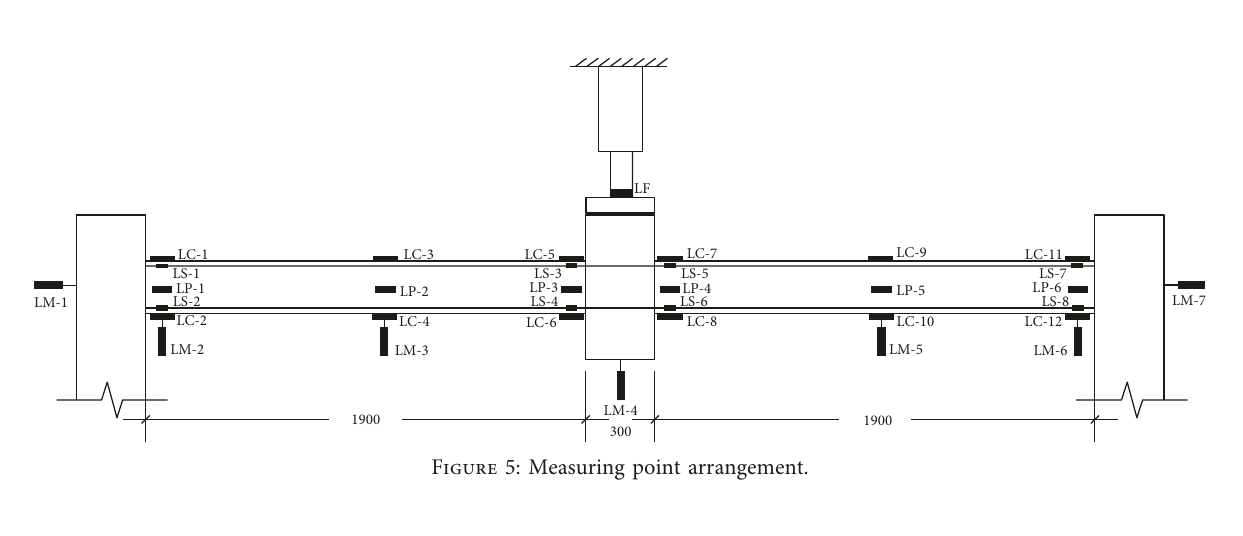
Figure 5: Measuring point arrangement.